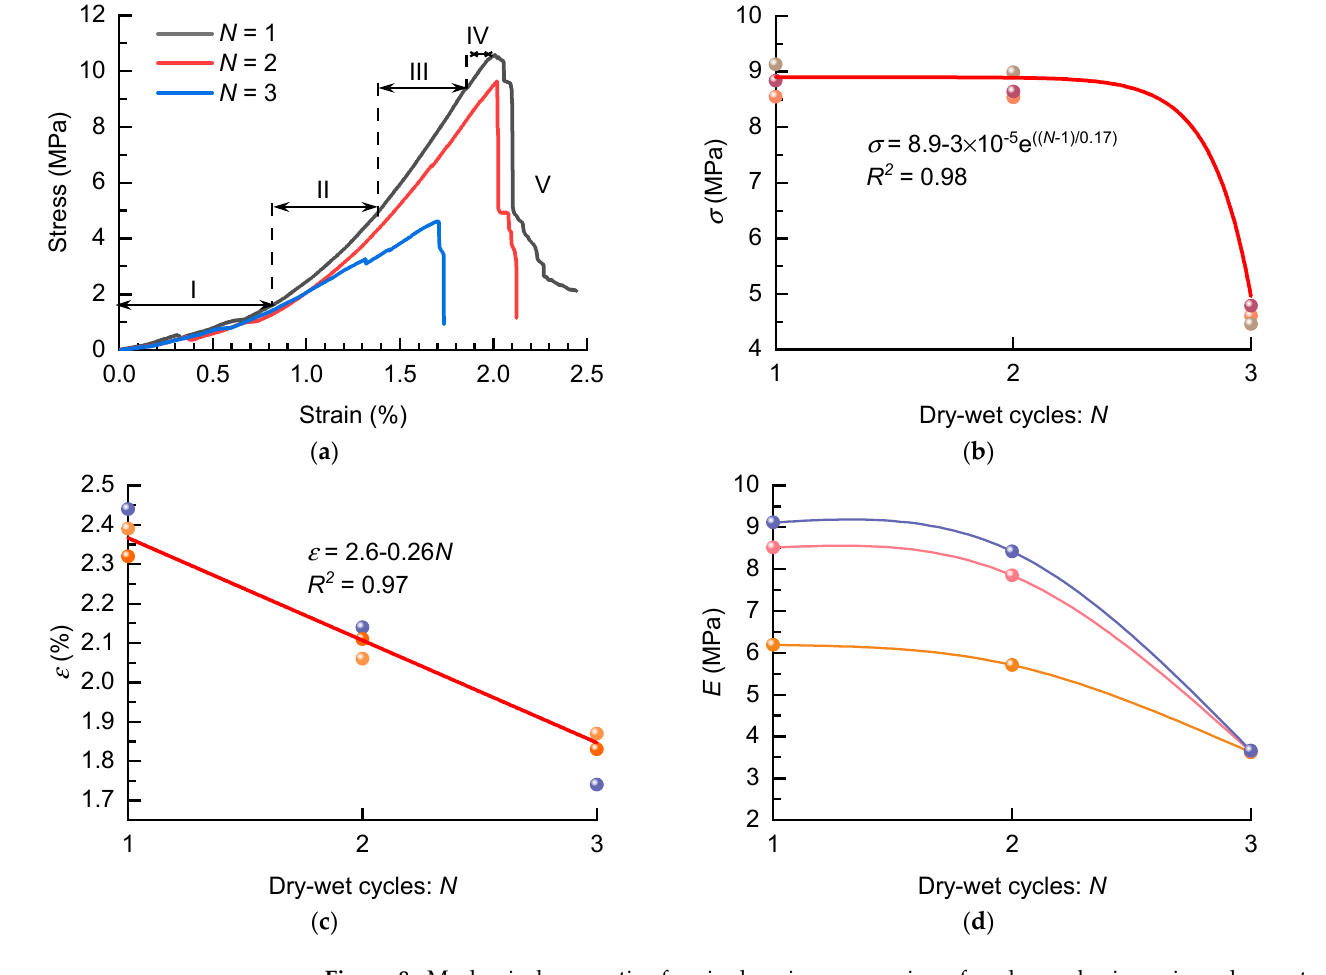
Figure 8. Mechanical properties for single-axis compression of coal samples in various dry–wet cycles. They should be listed as: ( a ) stress–strain, ( b ) uniaxial compressive intensity, ( c ) maximum pressure, and ( d ) modulus of elasticity.